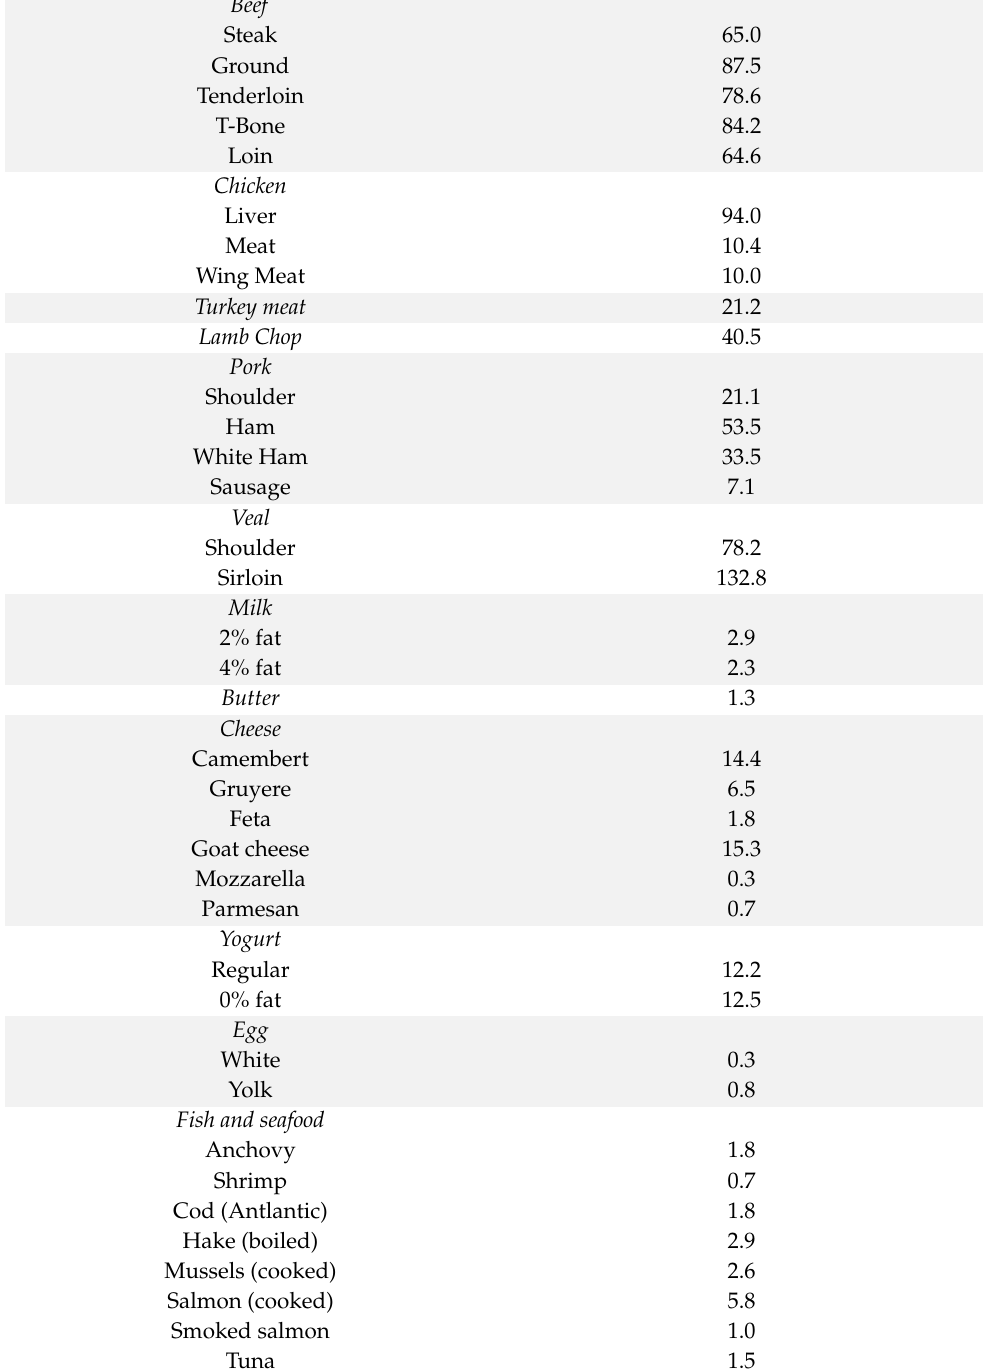
Table 2. L-carnitine raw food contents in mg for 100 g